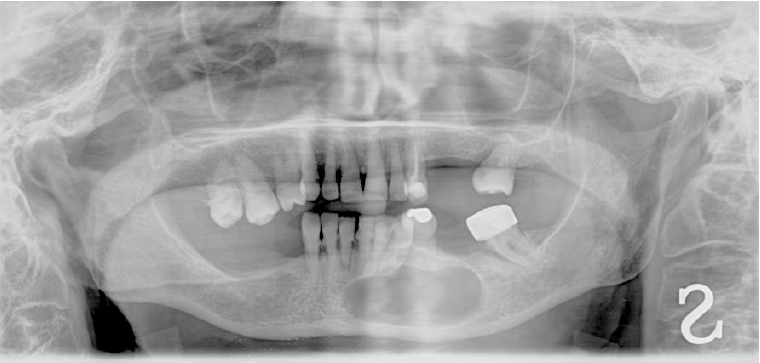
Figure 2. Initial OPG showing a wide radiolucent area in the mental area.